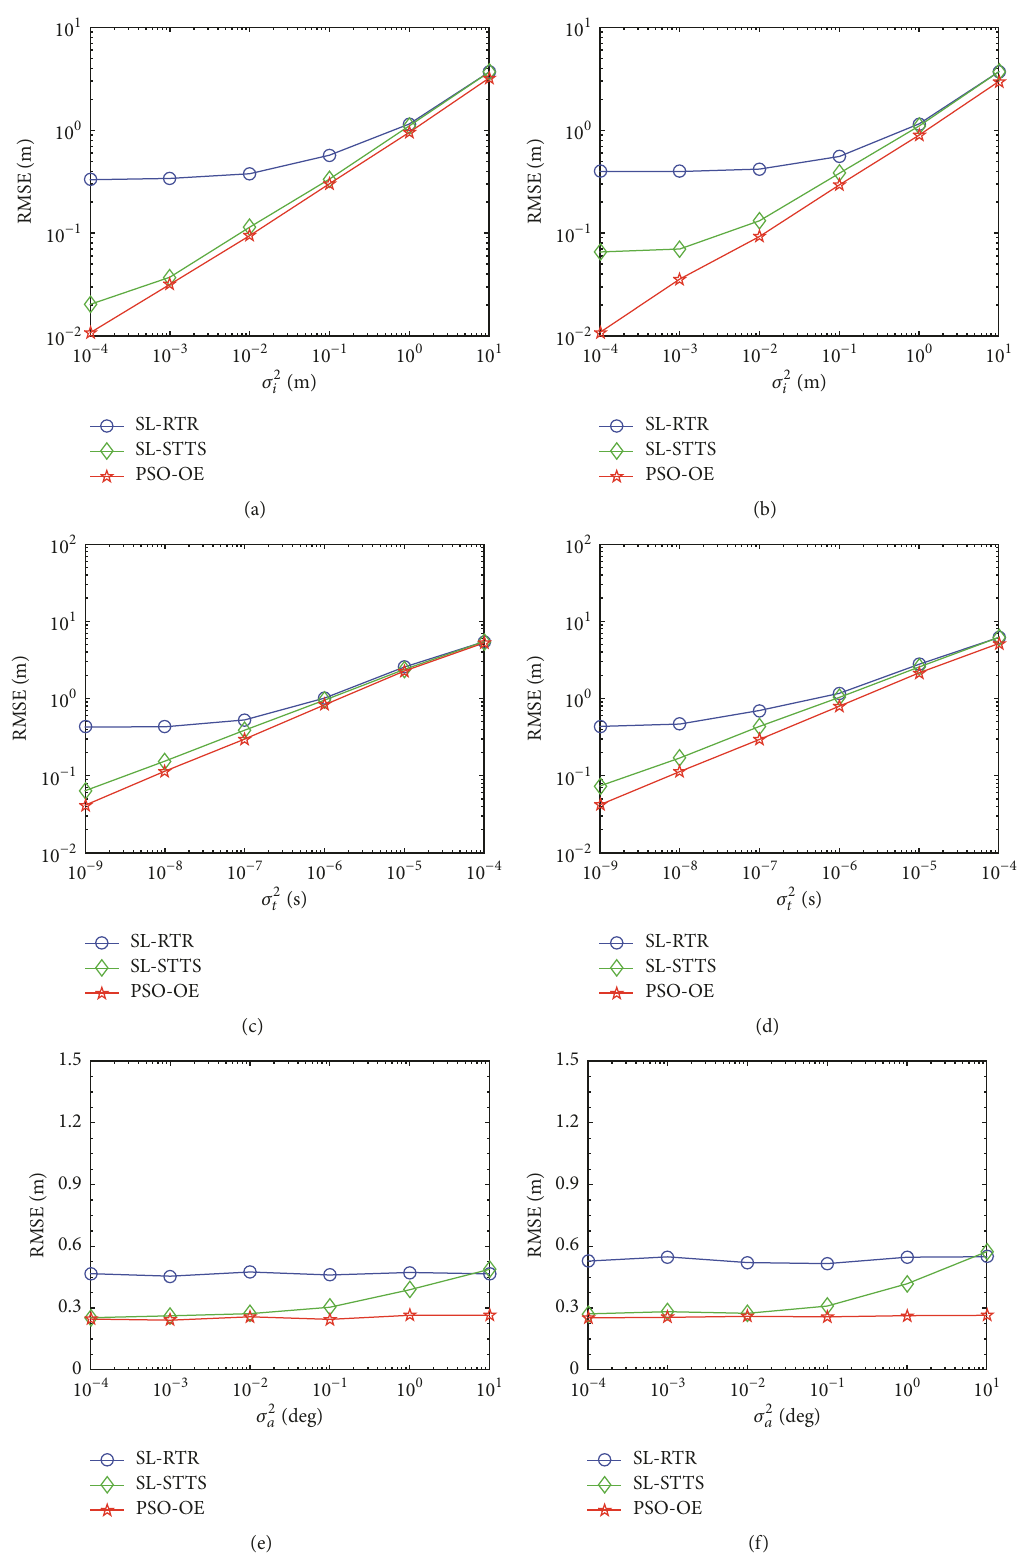
Figure 7: The root mean square error of different noise levels in the second experiment: ((a), (b)) RMSE versus variance of distance measurement noise; ((c), (d)) RMSE versus variance of time measurement noise, set 𝜎 2 𝑎 = 0 ; ((e), (f)) RMSE versus variance of angle measurement noise, set 𝜎 2 𝑡 = 10 −7 . The only difference is that the current is not taken into account in (a), (c), and